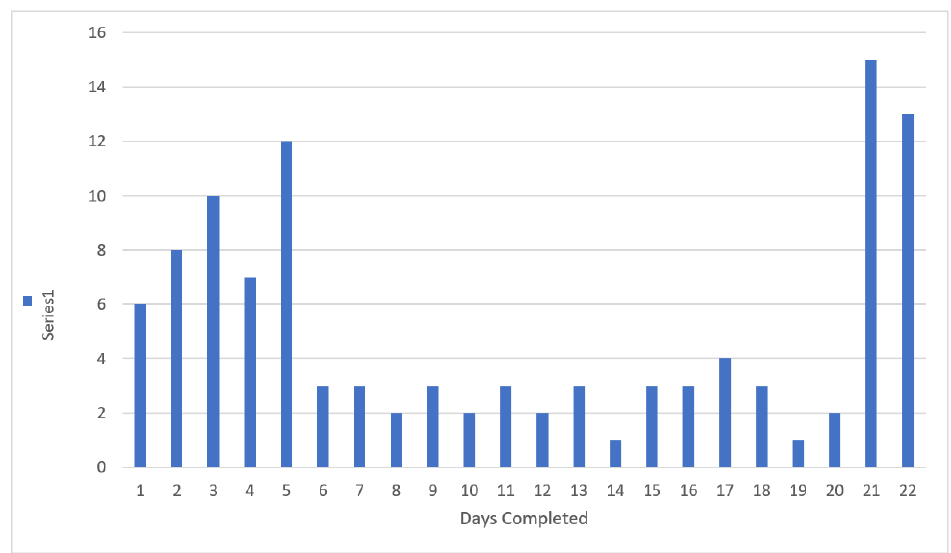
Figure 4. Days completed of the 21 Day Stress Detox programme. (Day 22 was ‘content-free’ and consisted of a message prompting the participant to complete the post-intervention assessment.) The average number of completed modules was 19.3 ( SD = 15.3). Twenty-six percent ( n = 31) completed between 30 and 51 modules and 23% engaged with fewer than five modules. One participant accessed different modules 73 times (completing several modules more than once) during the programme.